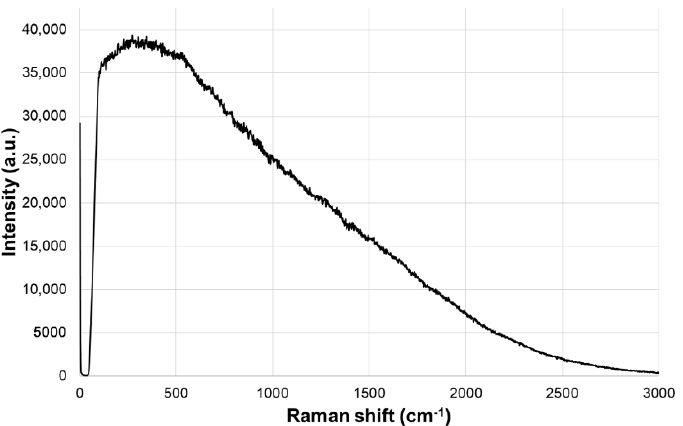
Figure 2. Spectra obtained for an Iberian ham sample, dominated by the fluorescence profile.